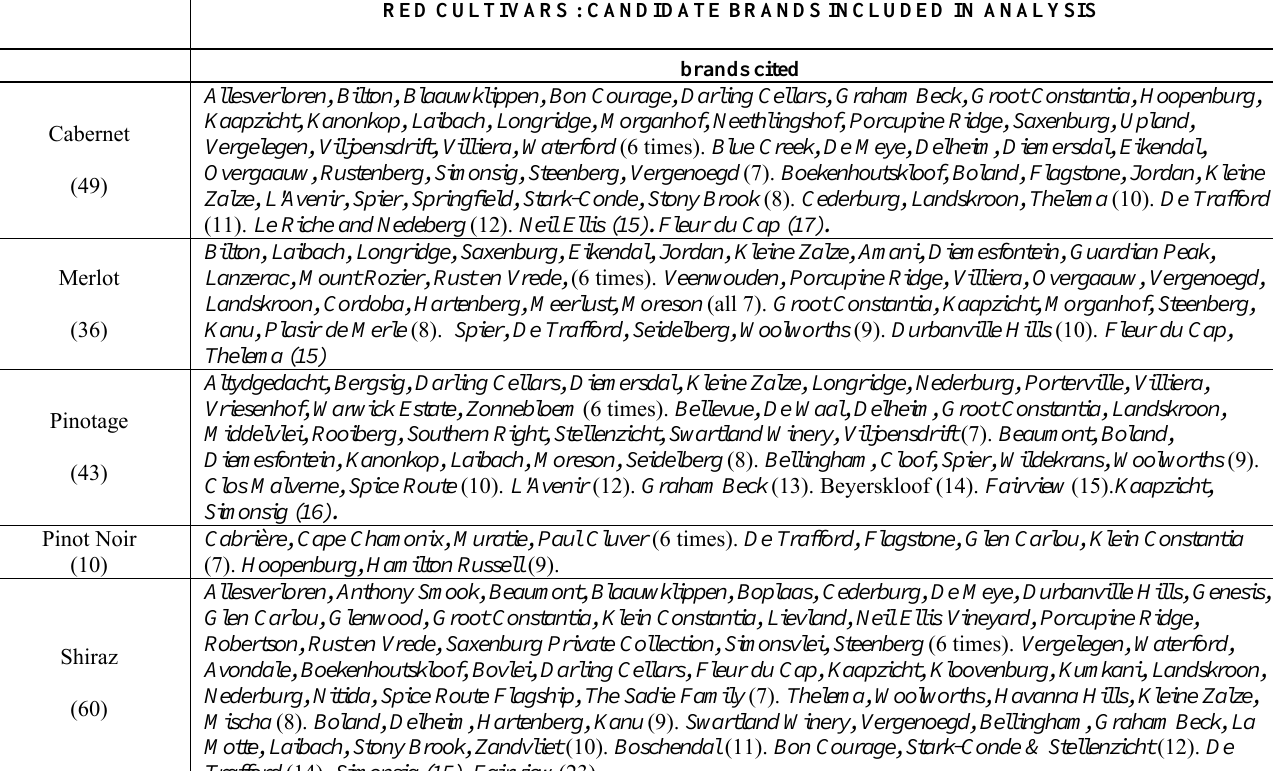
Table 4: Candidate brands (276 in all) as they appear in each of red wine varietal subsets. Citing frequency appears in brackets RED CULTIVARS : CANDIDATE BRANDS INCLUDED IN ANALYSIS brands